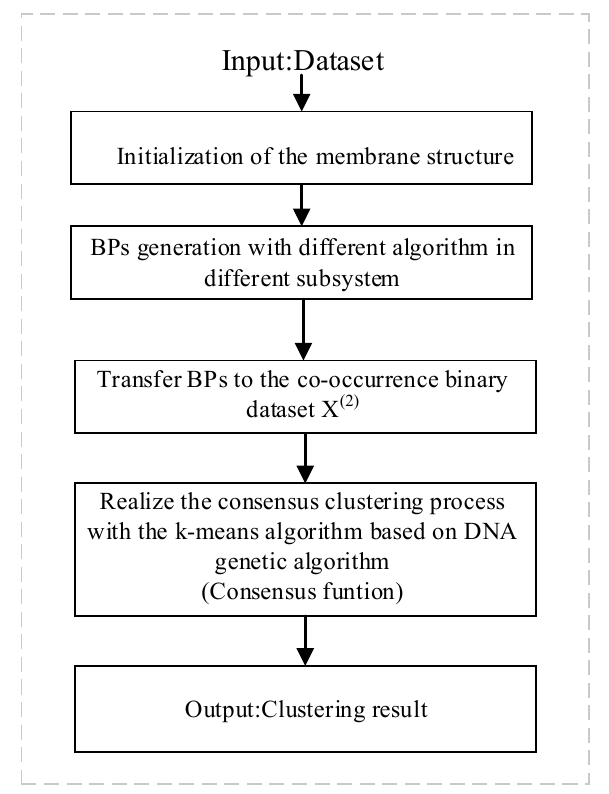
Figure 3. Flow chart of the proposed DNA-chain-hypergraph P System for consensus clustering (DCHP-FCC) algorithm.